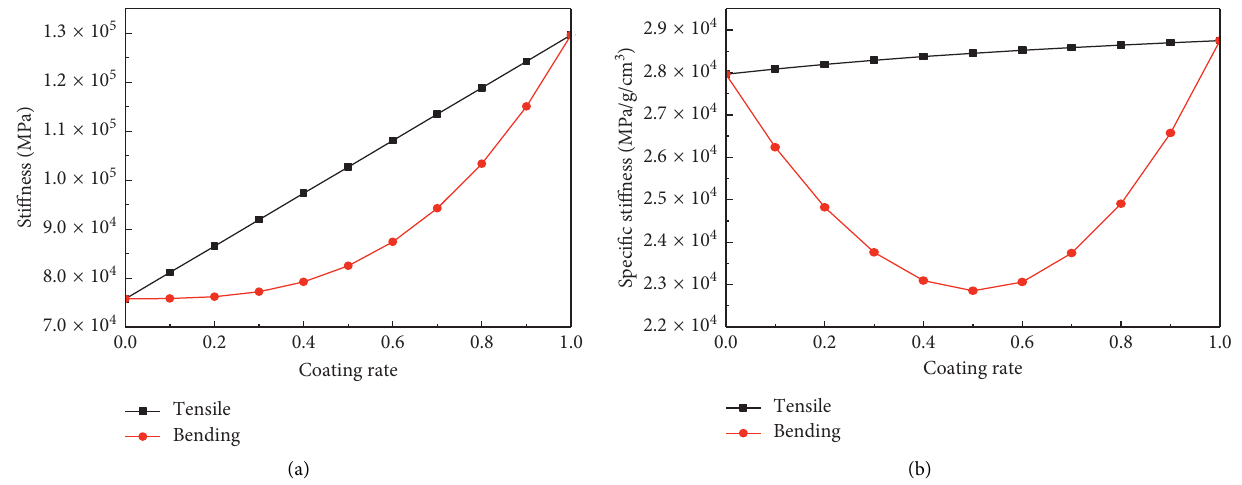
Figure 2: Stiffness and specific stiffness with the coating rate of Ti. (a) Stiffness of the laminated plate. (b) Specific stiffness of the laminated